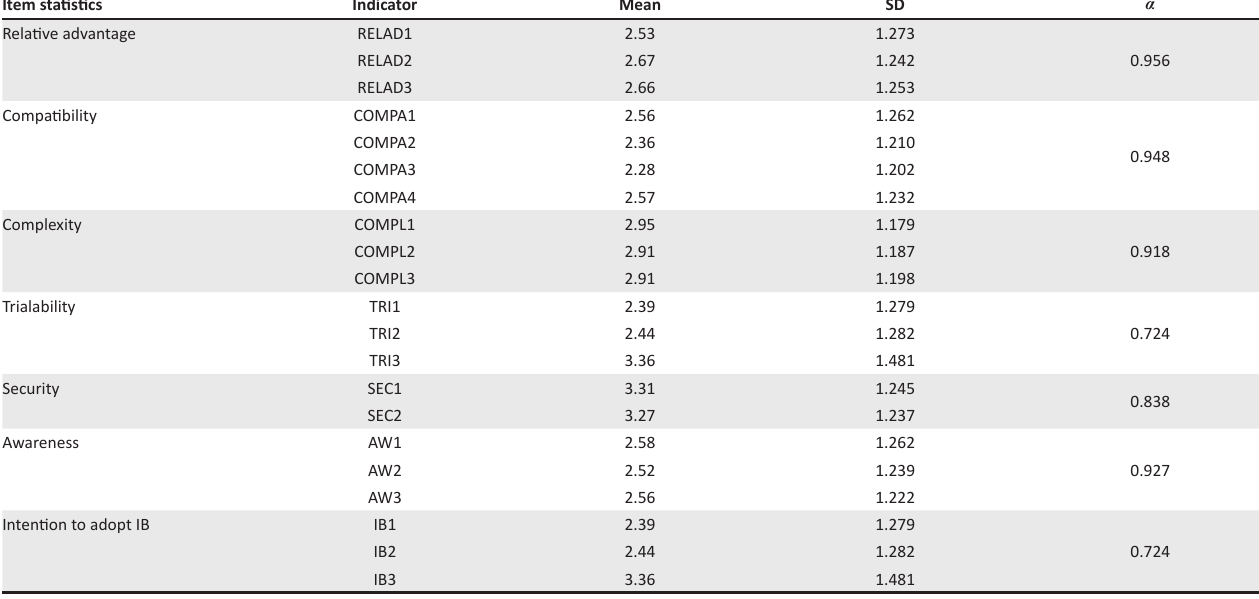
TABLE 1: Reliability analysis using Cronbach’s alpha.